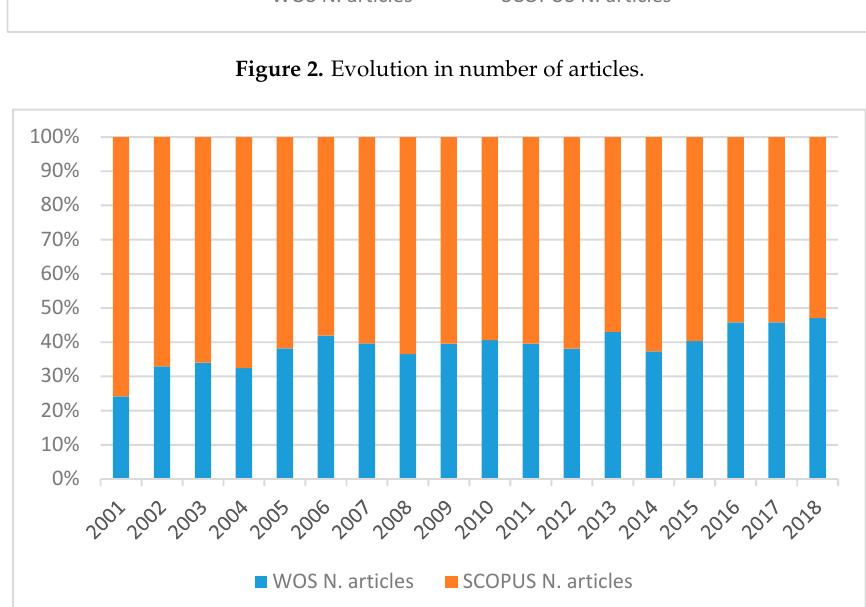
Figure 3. Average number of articles on WOS vs Scopus.